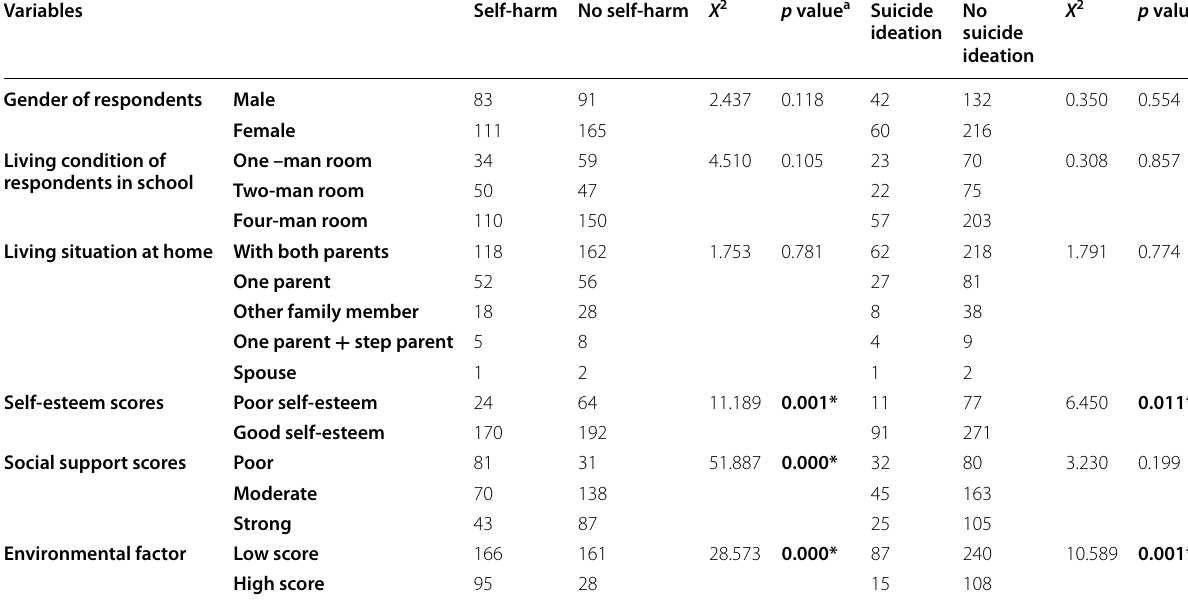
Key: * Statistically significant value p <0.05; a Chi-square test